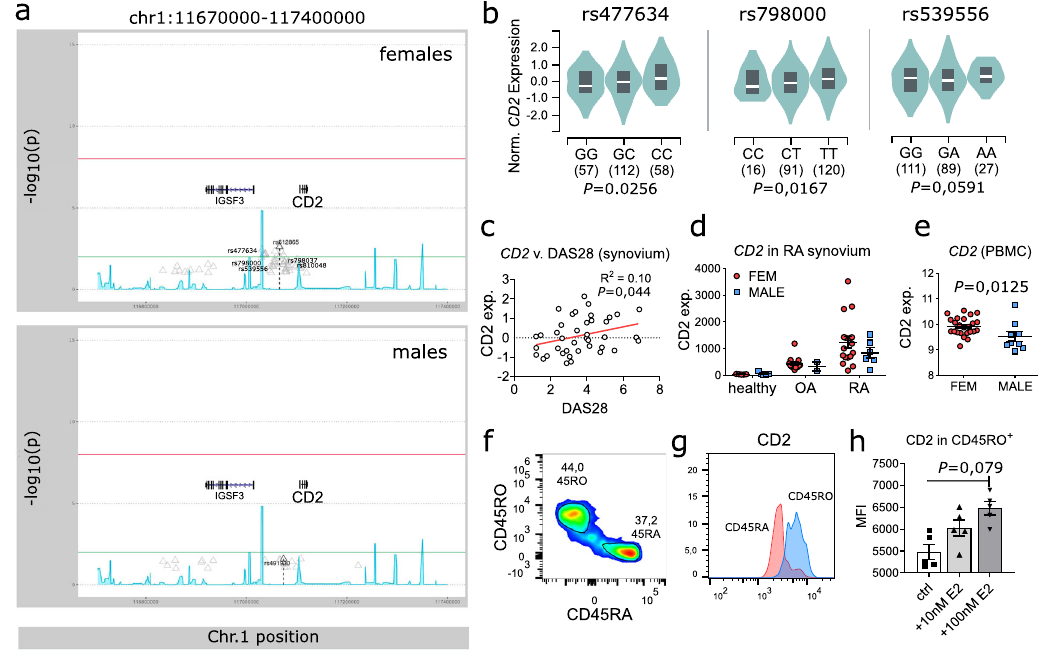
Fig. 7 E2-mediated regulation of CD2 is conserved in humans. a Genetic association data showing association between CD2 polymorphisms and rheumatoid arthritis (RA) in female (top) and male (bottom) patients (EIRA cohort, n = 1341 males and 3361 females). b Effect of indicated SNPs on expression of CD2 in human spleen as determined from GTEx database 65 . Number of samples is given in parenthesis below the graphs. Violin plots show Kernel density estimate KDE in green, interquartile ranges (25th/75th percentiles) in grey (squares), and the median in white (line). P values were obtained from GTEx, calculations are detailed in Oliva et al. 65 . c CD2 expression in synovia from RA patients plotted against disease activity (DAS28-CRP). Data was extracted from GEO Dataset GSE45867. R 2 and P were calculated using simple liner regression. d Expression of CD2 in synovial tissue from RA patients, osteoarthritis (OA) patients or healthy controls (GEO GDS5401-3). Females are shown in red and males in blue. e Expression of CD2 in PBMCs from healthy males and females (GEO GDS5363). f CD2 expression on antigen experienced CD45RO + or naïve CD45RA + CD4 + T cells from blood of a healthy donor. Data is representative of n = 3 independent human biological replicates. The experiment was done twice with similar results. g , h CD2 expression in CD45RO + T cells after 24 h incubation with 10 – 100 nM E2. Representative fl ow cytometry histogram showing CD2 expression in g and quanti fi cation in h . Data shown is pooled from two independent experiments. In all fi gures, each dot indicates one independent human biological replicate. Data are summarised as mean (SEM). In d , e , and g , statistical signi fi cance was evaluated using a two-tailed non-parametric Mann – Whitney U test. Sequential fl ow cytometry gating strategies for f – h are provided in Supplementary fi g.